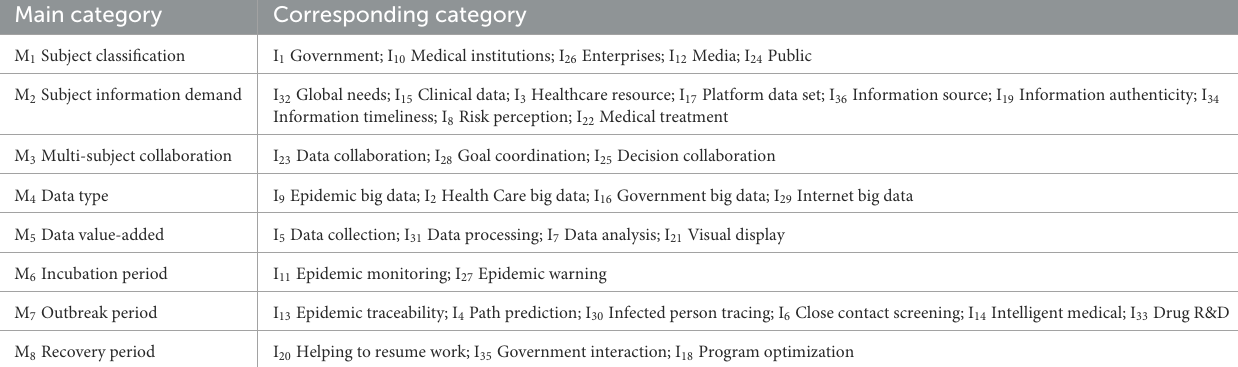
TABLE 2 Axial coding forms the main